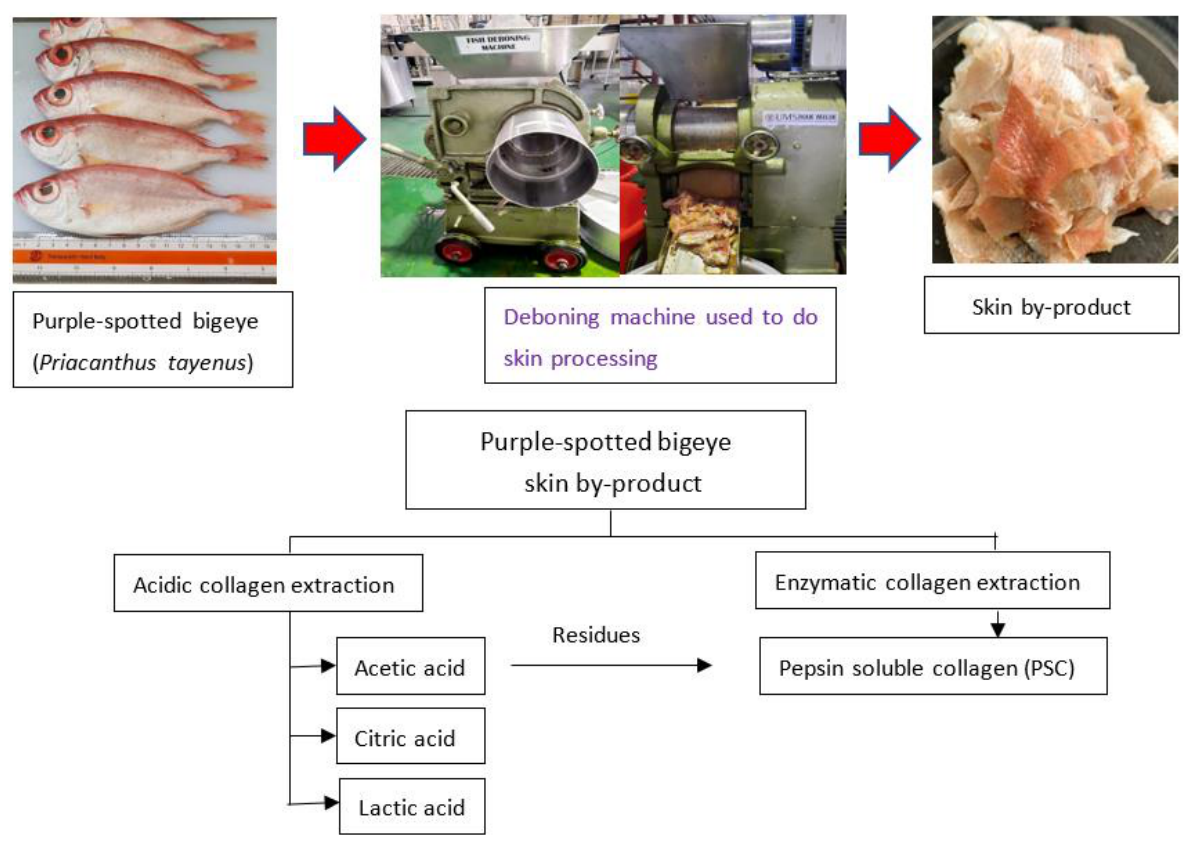
Figure 5. Schematic representation of the extraction processes to obtain collagen from skin purple- spotted bigeye snapper ( Priacanthus tayenus ).